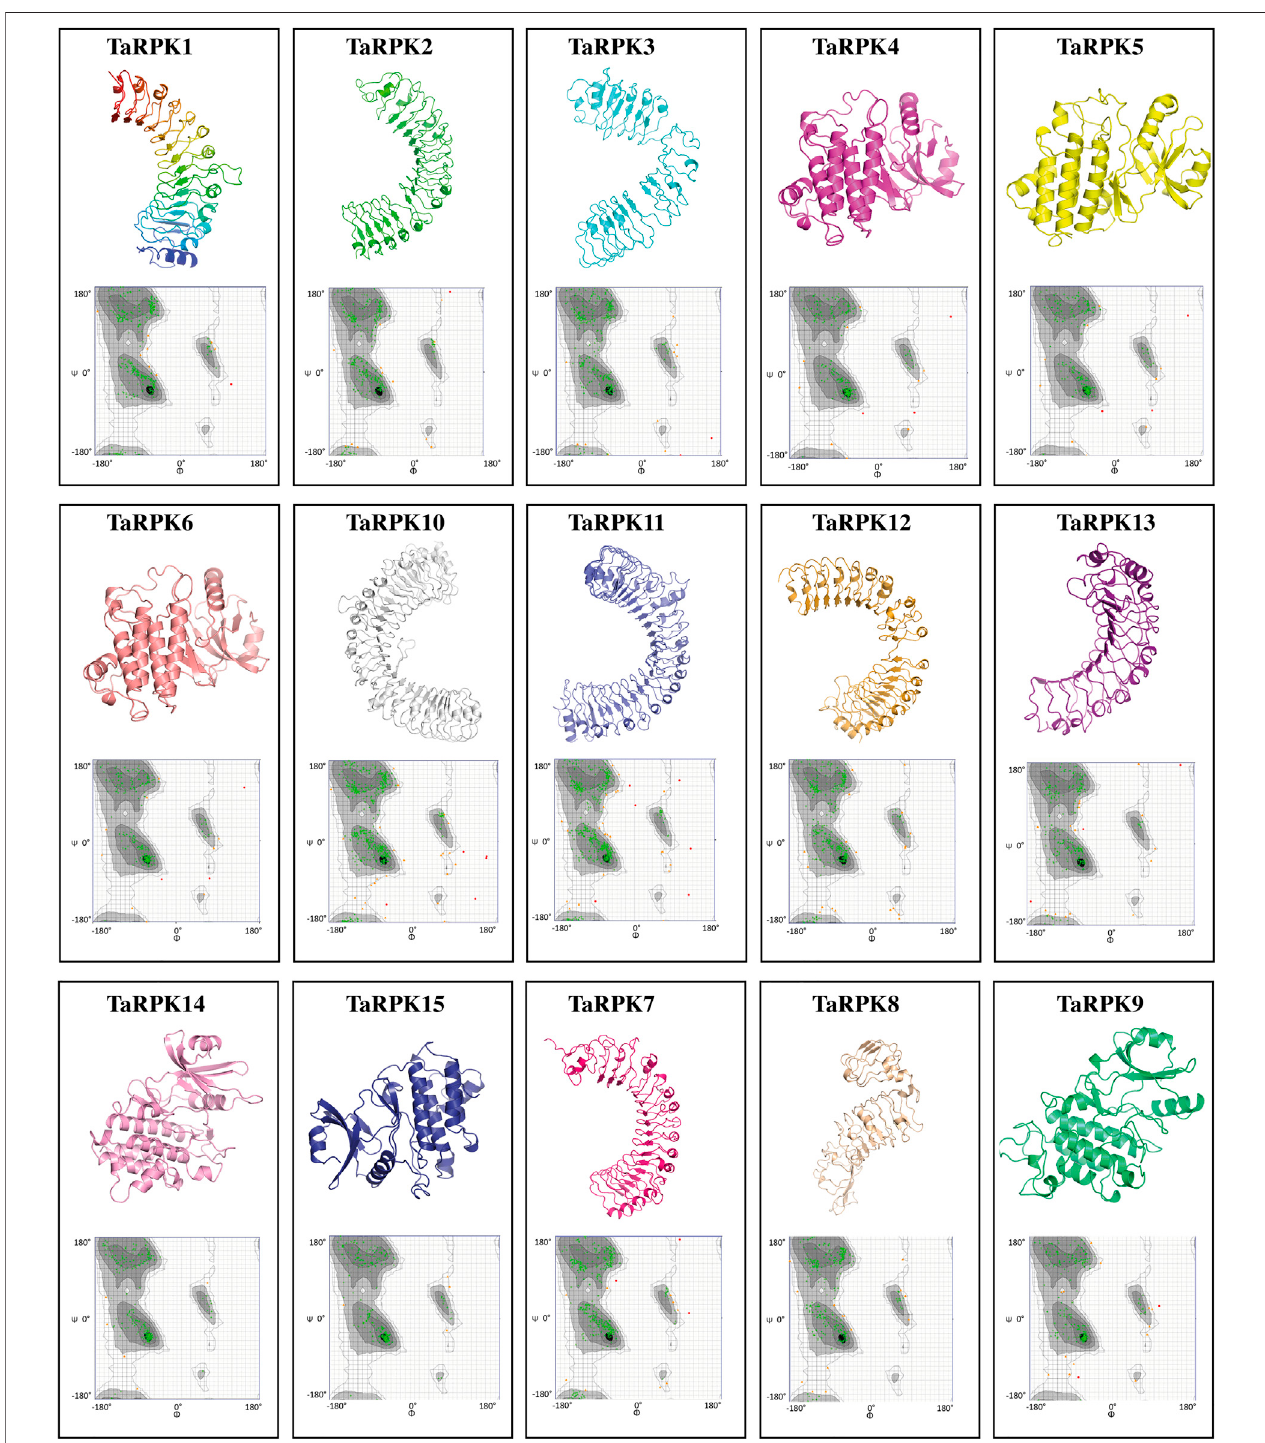
FIGURE 7 | 3D structure of TaRPK1 proteins along with Ramachandran plots in T. aestivum . In all 3D protein structures, the spirals are helices, broad strips with arrow heads are beta-pleated sheets, and thin loops are coils. In Ramachandran plots, dark black, gray, and light gray represent highly preferred conformations with Delta ≥ − 2. White with a black grid denotes preferred conformations with − 2 > Delta ≥ − 4. White with gray grid symbolizes questionable conformations with Delta < − 4. The green crosses signify highly preferred observations, brown triangles specify preferred observations, and red circles represent unfavorable observations.